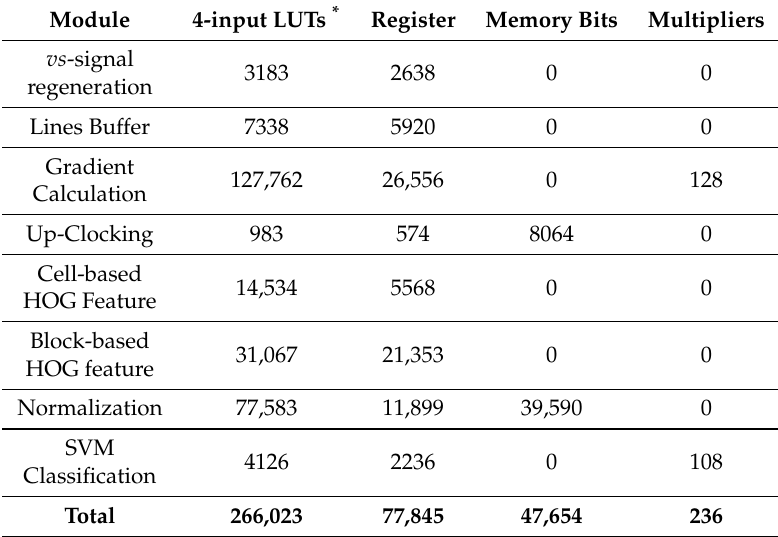
Table 2. Resource usage of each submodule in the digital image processing